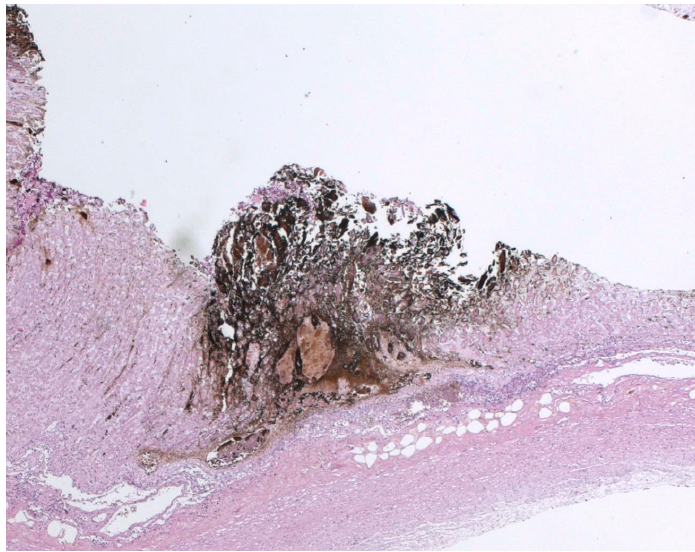
Figure 2. Microscopic analysis of WS of significant erosions (H+E staining).